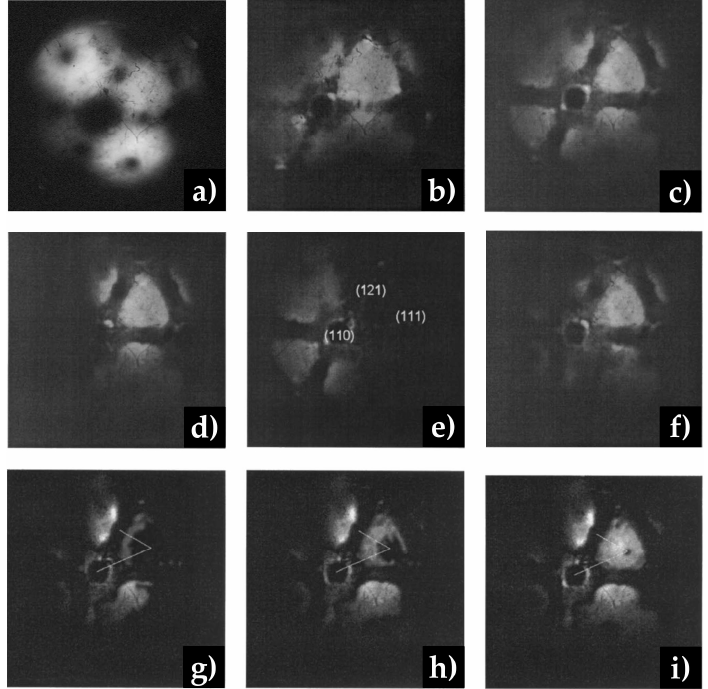
Figure 17. Imaging water diffusion by FEM: ( a ) Field emission pattern of a clean W tip.